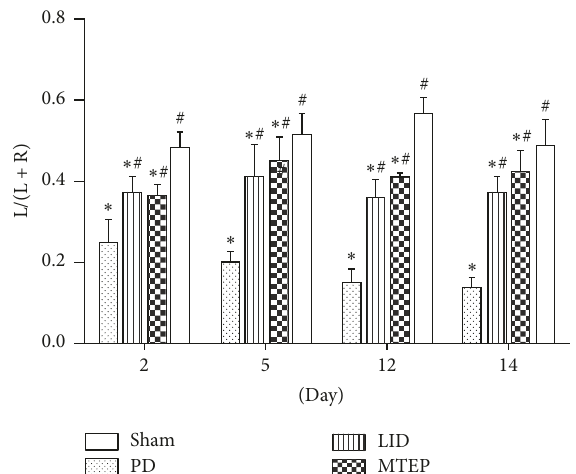
Figure 3: Spontaneous forelimb use of the rat in various experimen- tal groups. Cylinder test. ∗ indicates a significant decrease relative to the sham group ( ∗ 𝑝 < 0.01 ), and # indicates a significant increase from PD group ( # 𝑝 < 0.05 ). Columns indicate the mean, and bars indicate the SD; the cylinder test was performed on the 2nd, 5th, 12th, and 14th days, using one-way ANOVA followed by Bonferroni post hoc